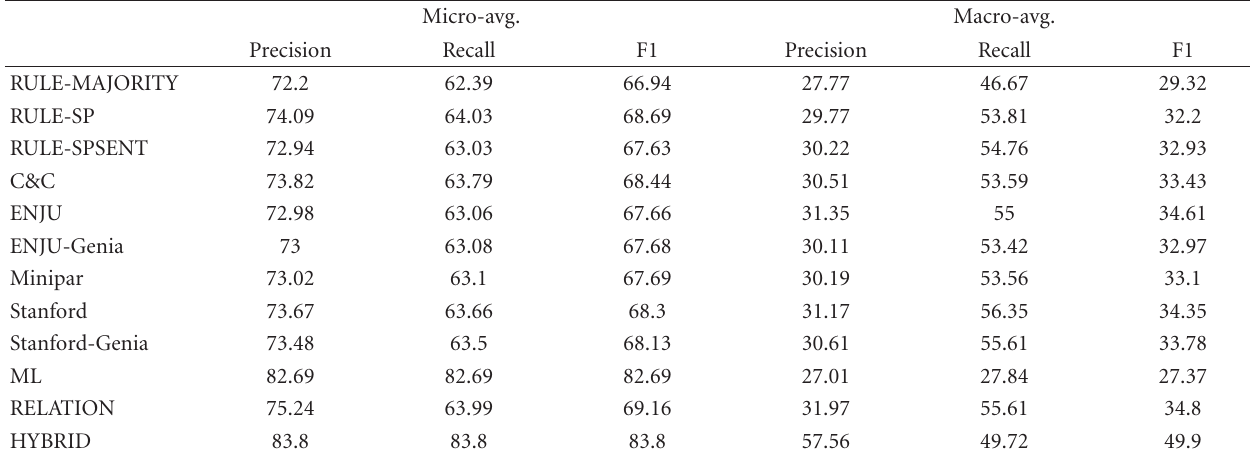
Table 7: The averaged evaluation results from Wang et al. [9].